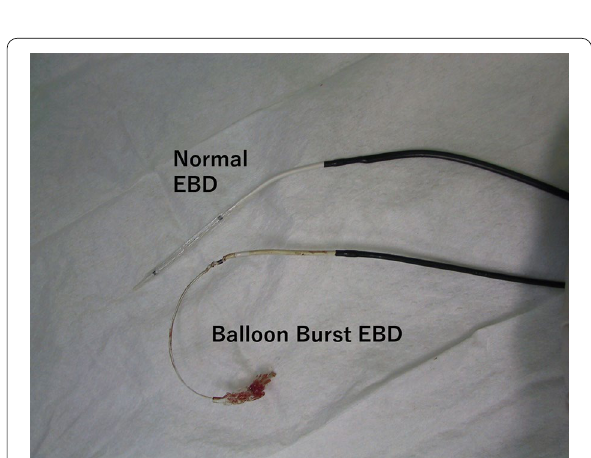
Fig. 6 The burst balloon of the EBD catheter. The burst balloon of the EBD catheter is shown in comparison to a normal balloon of an EBD